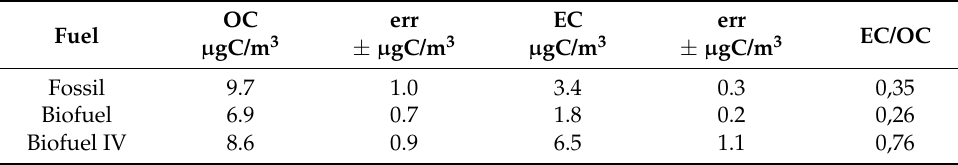
Table A5. Carbon species (OC, EC, and TC) measured during background monitoring. The data are reported as average for the whole fossil fuel and biofuel blend tests. Only biofuel test IV is reported